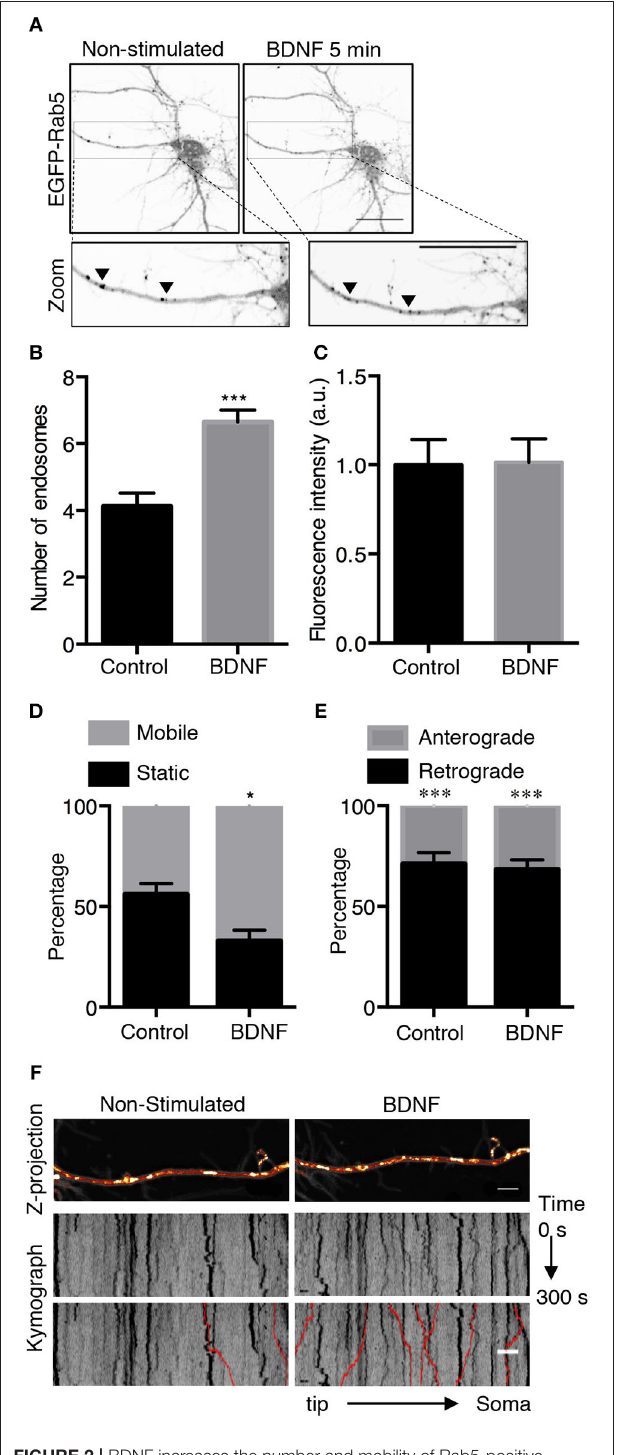
FIGURE 2 | BDNF increases the number and mobility of Rab5-positive endosomes in dendrites. (A) Representative image illustrating changes in the number of Rab5-positive endosomes in nonstimulated conditions (control) and after 5min of BDNF treatment (BDNF) in the same neuron. EGFP-Rab5 endosomes are observed as dark spots within dendrites. A zoomed-in image